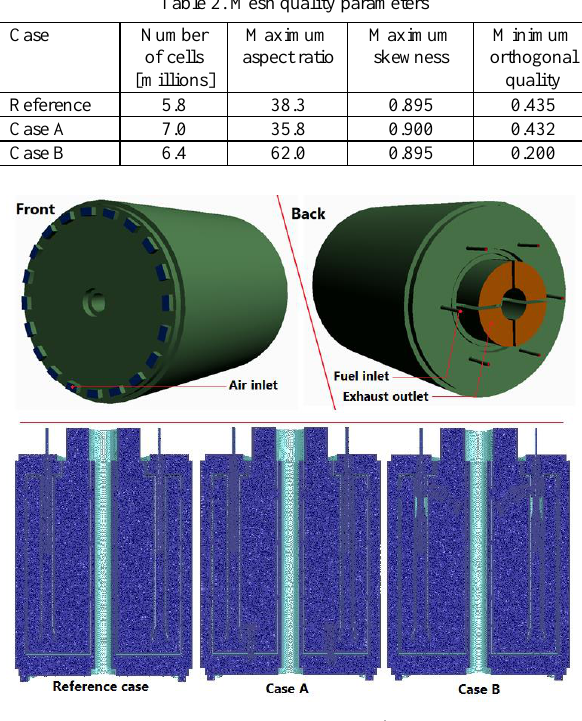
Fig. 4. Cross sectional view of 3D model of modified combustor (case B)